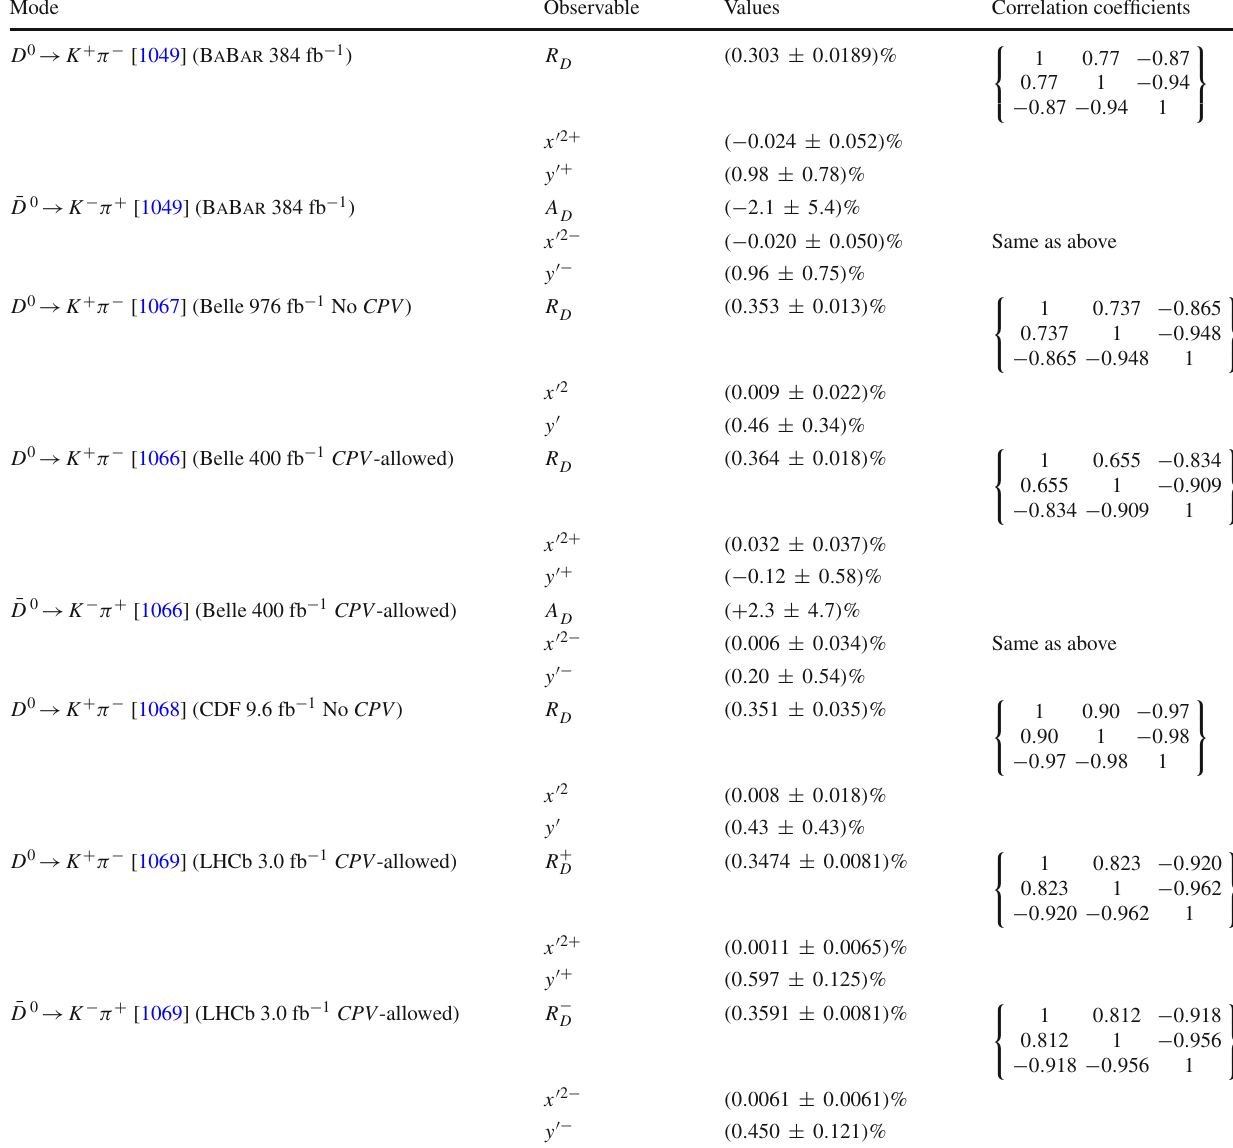
Table 260 Time-dependent D 0 → K + π − observables used for the global fit. The observables R + = R ( 1 ± A ) via R ± D D D